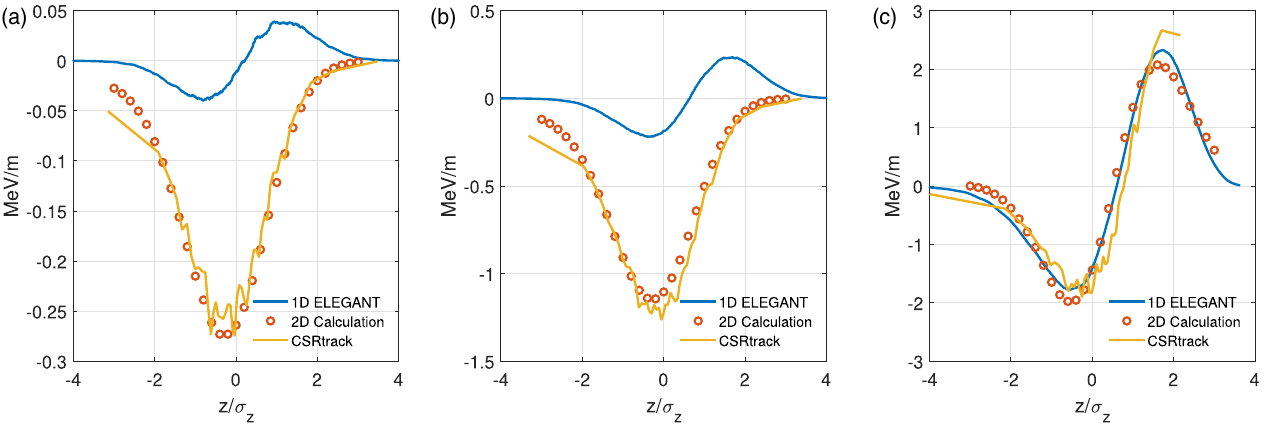
FIG. 5. Wakes calculated in 1D model are shown by blue lines and ones calculated in our 2D model and CSRTRACK are shown by circles and yellow lines respectively: (a) in the middle of the second magnet, (b) in the middle of the third magnet, and (c) in the middle of the fourth magnet. The coordinate z is normalized by the rms bunch length, σ z ð s Þ , at the location of the bunch.